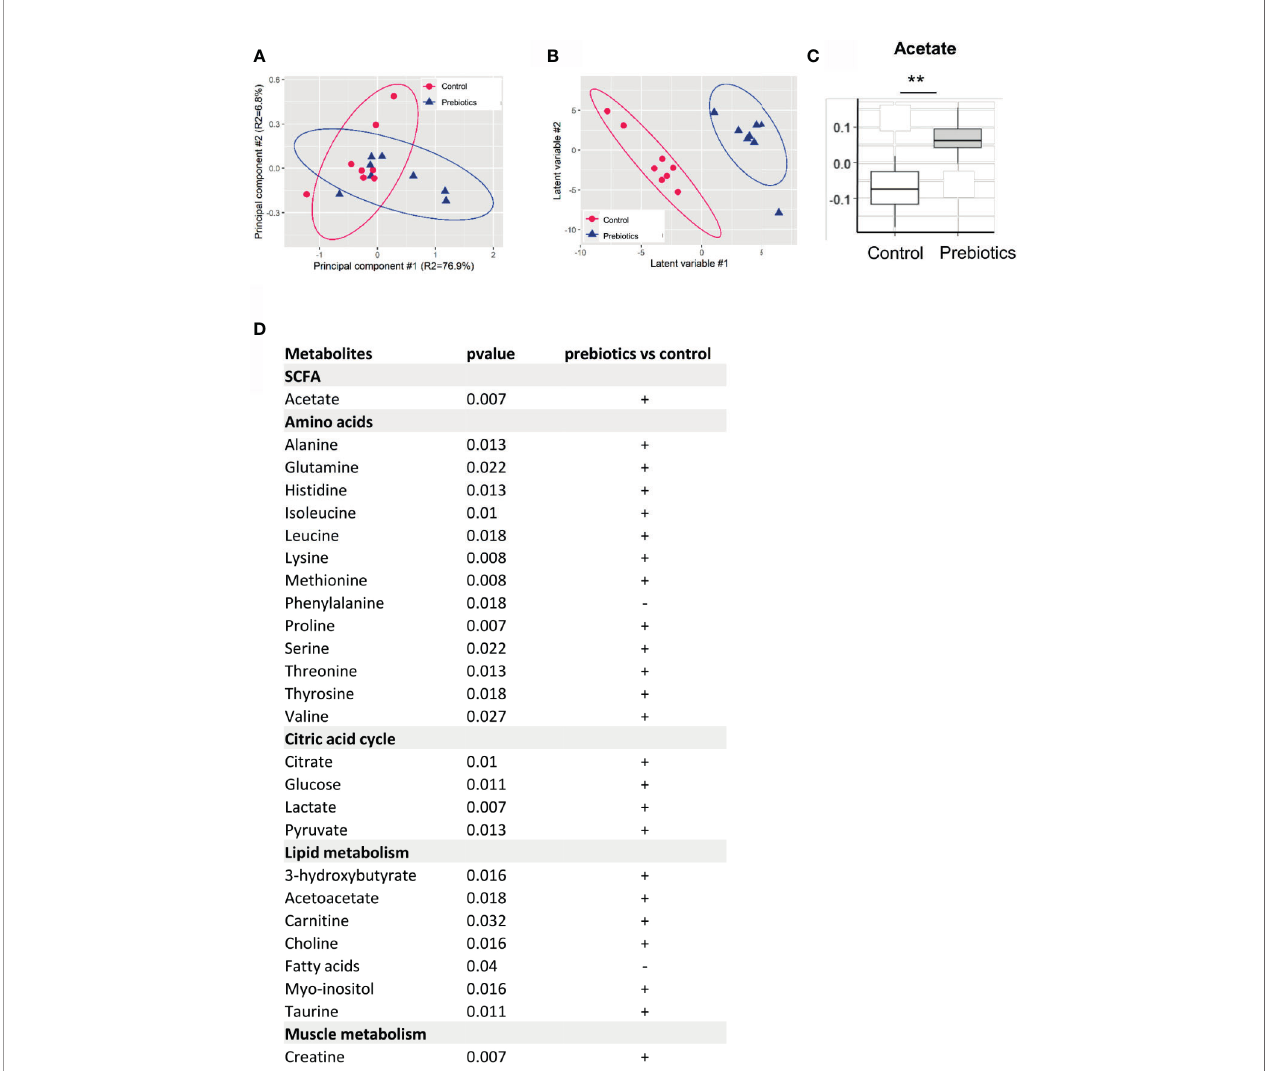
FIGURE 3 | Effects of GOS/inulin supplementation on the concentrations of amniotic fl uid metabolites. (A) Two-dimensional PCA score plot of 1H NMR integrated spectra of amniotic fl uid samples (circle: control, n = 8; triangle: supplementation, n = 8). (B) Two-dimensional PLS-DA score plot of OSC- fi ltered and Pareto-scalde 1H NMR integrated spectra of amniotic fl uid samples (circle: control, n = 8; triangle: supplementation, n = 8). (C) Boxplot of discriminant (VIP ≥ 1.0) and signi fi cant (FDR-corrected p-value ≤ 0.05) features: comparison of the median concentrations of butyrate and acetate between the control (white) and prebiotic-supplemented (gray) groups. (D) Table of discriminant metabolites in the amniotic fl uid of dams fed a control or prebiotic diet. **p <